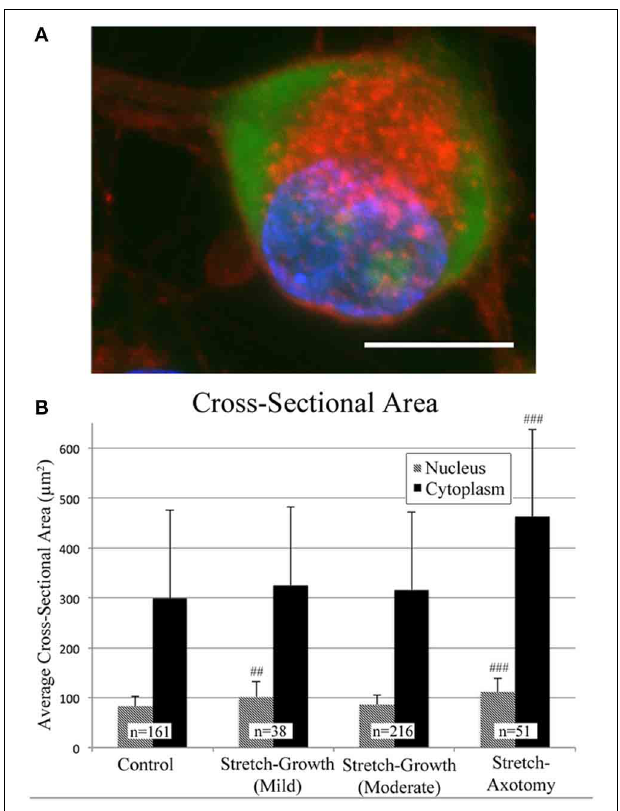
FIGURE 9 | Morphological analysis of soma following axon stretch. (A) Example of a DRG neuron as stained for analysis using wheat germ agglutinin (red), Nissl stain (green), and DAPI (blue); bar = 10 μ m. (B) Mild and moderate stretch-growth paradigms resulted in normal cytoplasmic cross-sectional areas. Stretch-axotomized neurons had significantly larger cytoplasms and nuclei compared to controls ( p < 0 . 0001 for cytoplasms and nuclei). ‘##’ and ‘###’ indicate p < 0 . 005 and p < 0 . 0005 , respectively, compared to